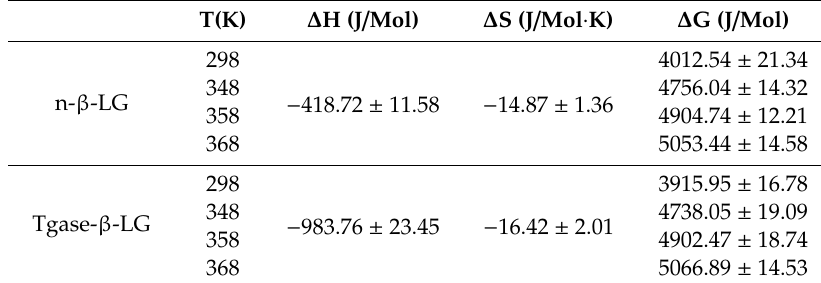
Table 2. Thermodynamic parameters for binding between β -LG in native and cross-linked states and ca ff eic acid at di ff erent